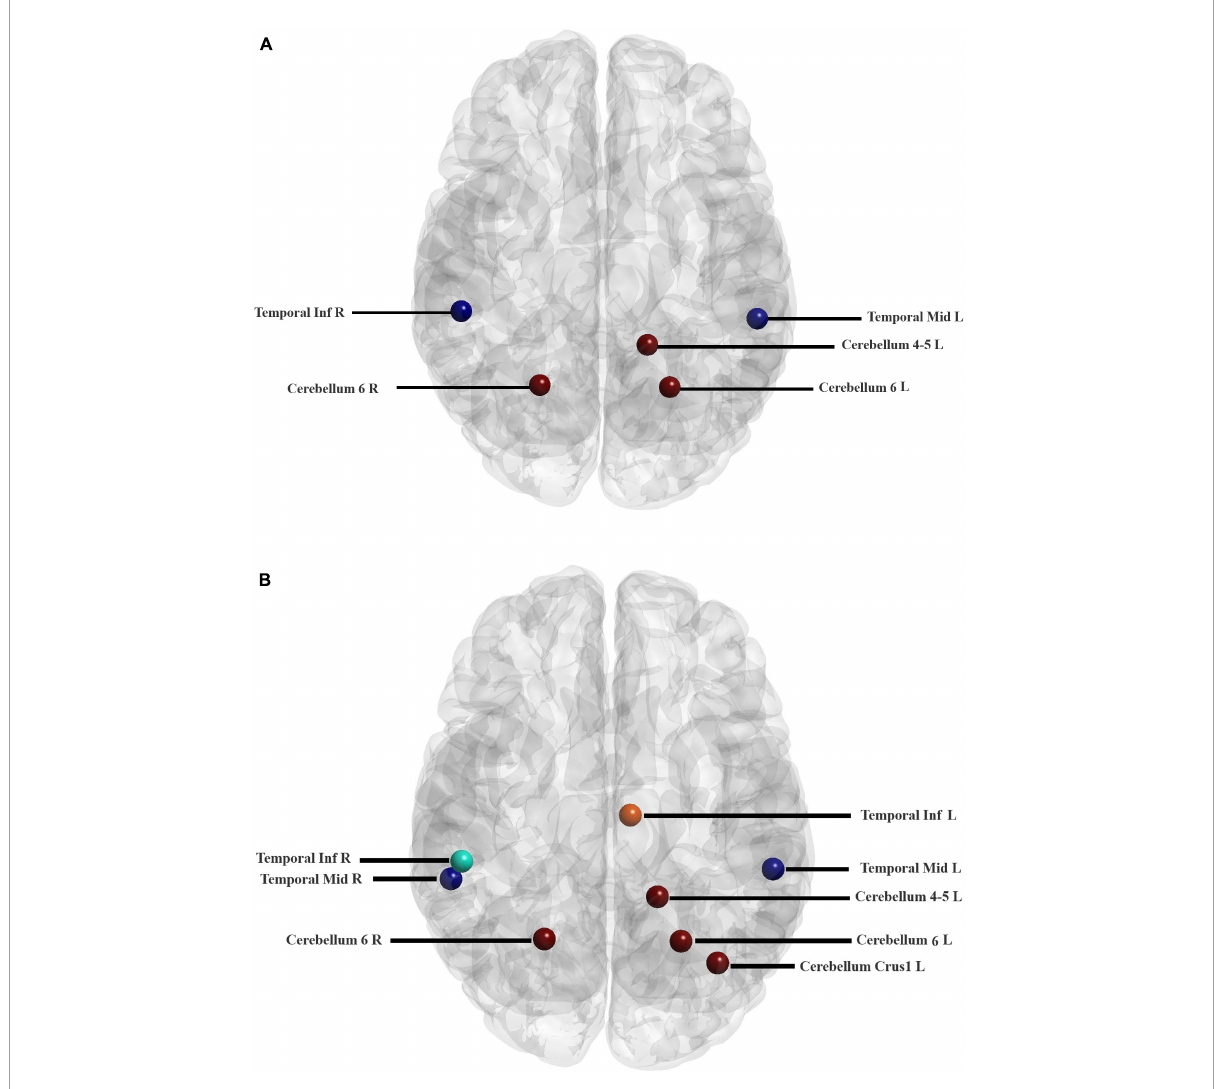
FIGURE6 Locations of the hub regions of two groups in the AAL atlas (listed in Table 5 ). Hub regions of ADHD children (A) and TD group (B)